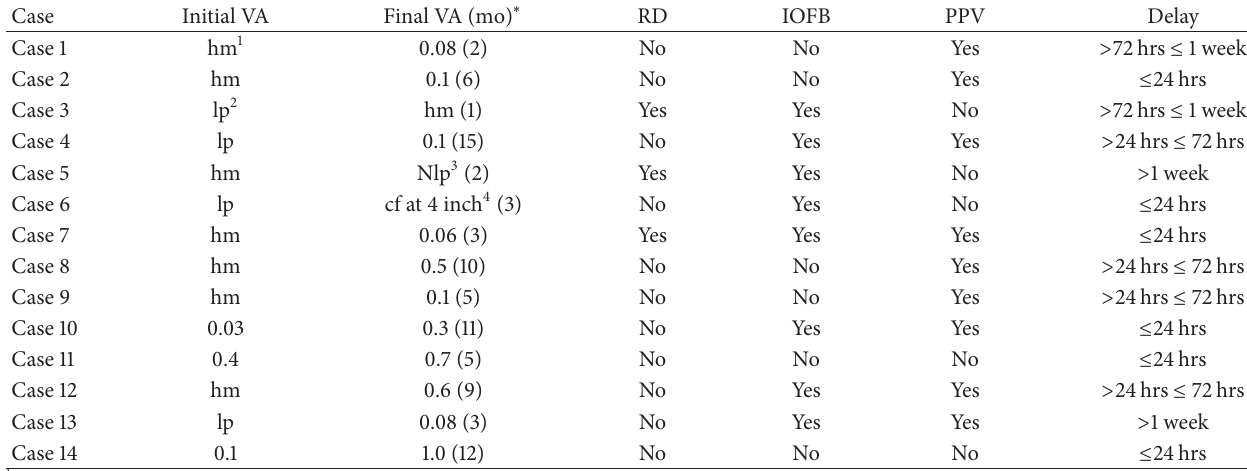
Table 3: Synthesis of the data on our traumatic endophthalmitis